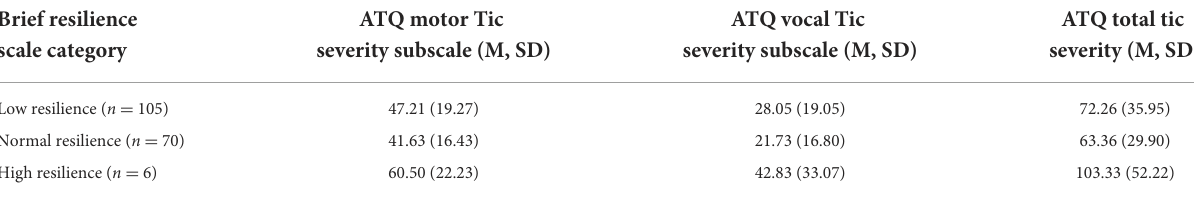
TABLE 2 Total tic severity scores presented by resilience threshold.